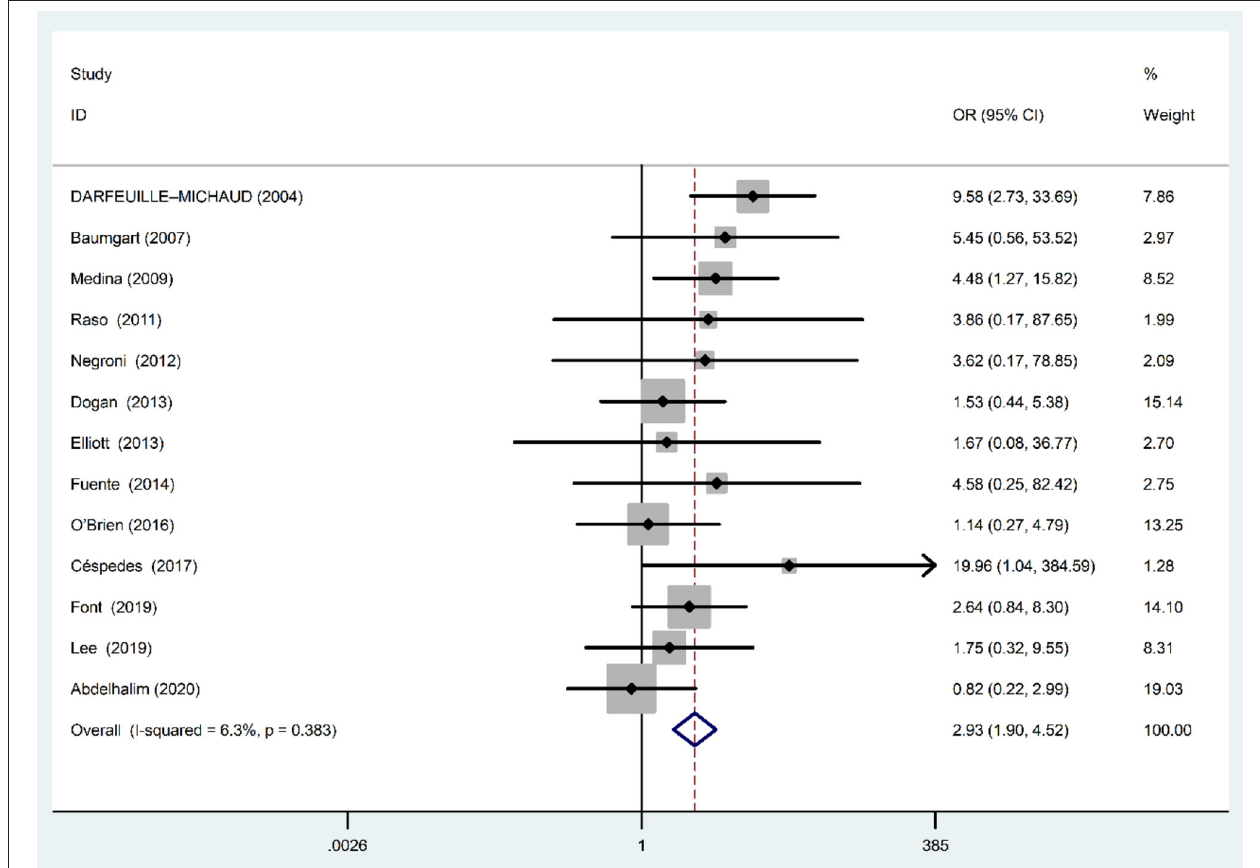
FIGURE 2 | Forest plot of the association between AIEC rate and risk of IBD.